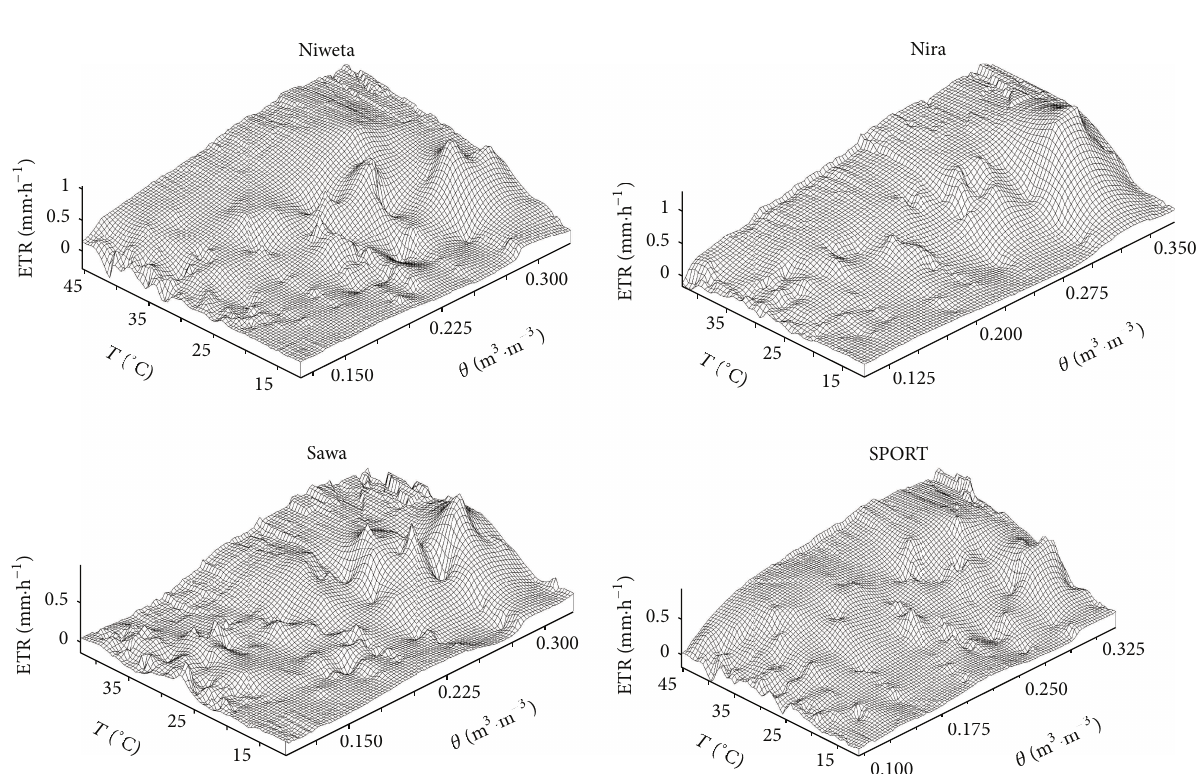
Figure8: Maps ofevapotranspiration fortheturfgrasses. 𝜃 isvolumetric moisturemeasured atthedepth of2.5 cm, 𝑇 istemperature measured at the depth of 2.5 cm, and ETR is